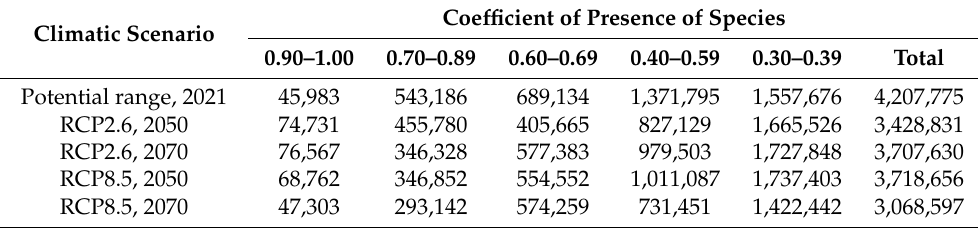
Table 4. Areas (km 2 ) of bioclimatic ranges of H. rufipes